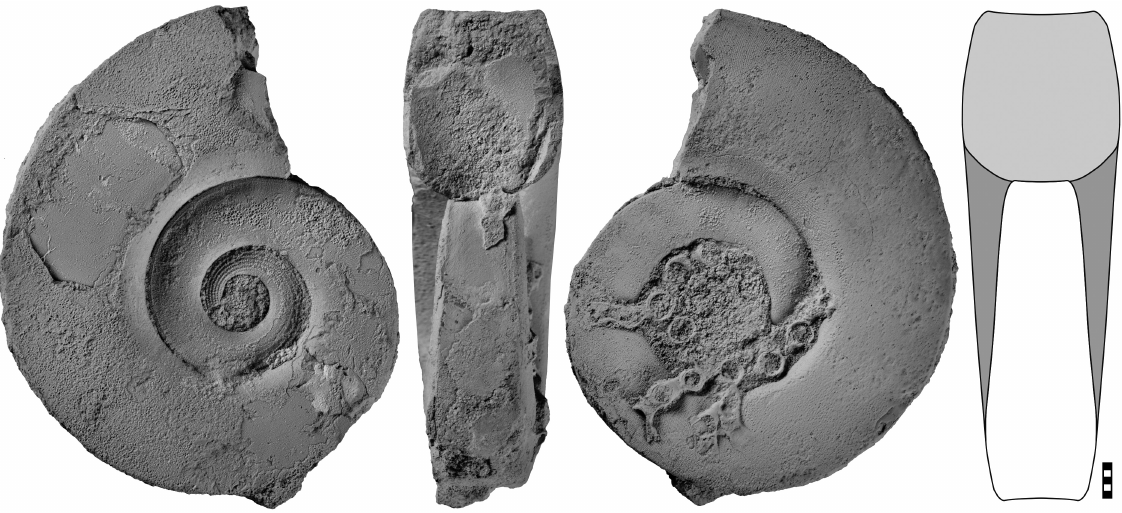
Fig. 29. Maccoyoceras concavum sp. nov., holotype MB.C.30486 (Wendt and Kaufmann 1995 Coll.) from Azzel Matti. Scale bar units = 1 mm.